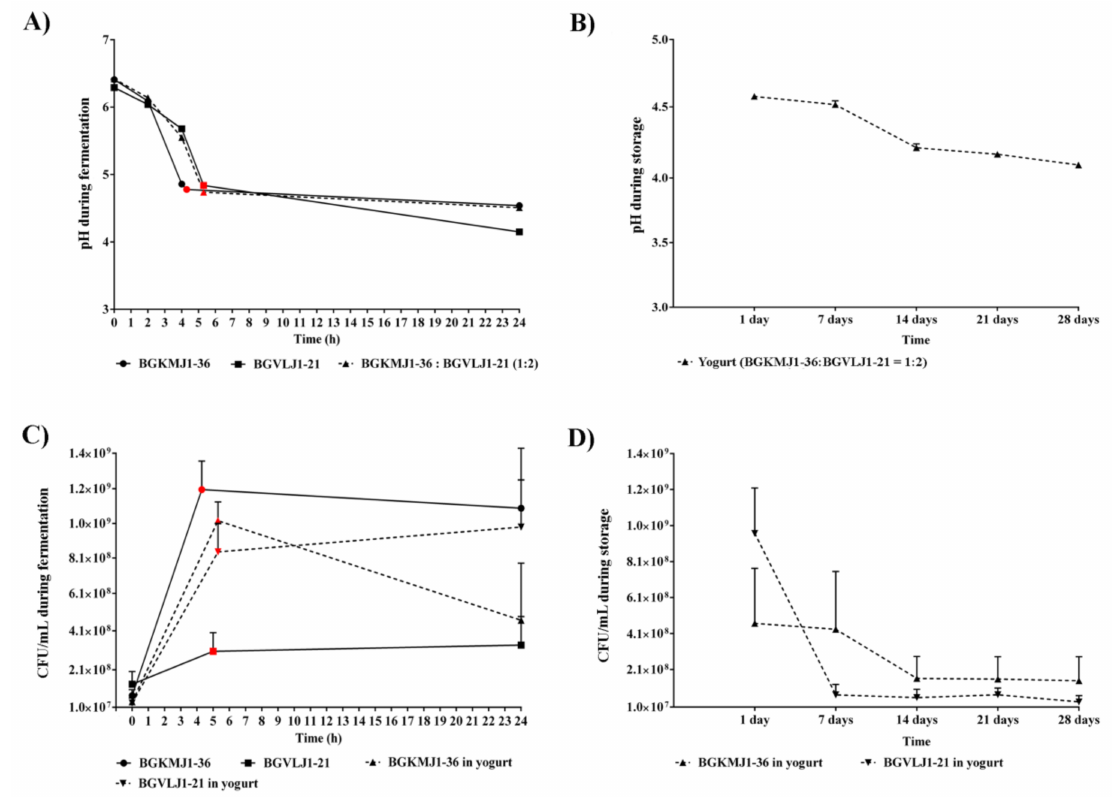
Figure 1. Acidification and growth dynamics of Streptococcus thermophilus BGKMJ1-36 and Lactobacillus bulgaricus BGVLJ1-21 strains during milk fermentation and storage. ( A ) Acidification curve of BGKMJ1-36 (circle), BGVLJ1-21 (square), and mix of BGKMJ1-36, and in ratio 1:2 (dashed line, triangle) during milk fermentation; ( B ) acidification curve of yogurt during storage at 4 ◦ C; ( C ) growth of BGKMJ1-36 (circle), BGVLJ1-21 (square), individually, as well as in mix in ratio of 1:2 ratio (dashed line, triangle) colony forming unit per milliliter (CFU / mL) during fermentation; ( D ) CFU / mL during storage at 4 ◦ C. Note: circles, squares, and triangles colored in red represent the time of coagulation during milk